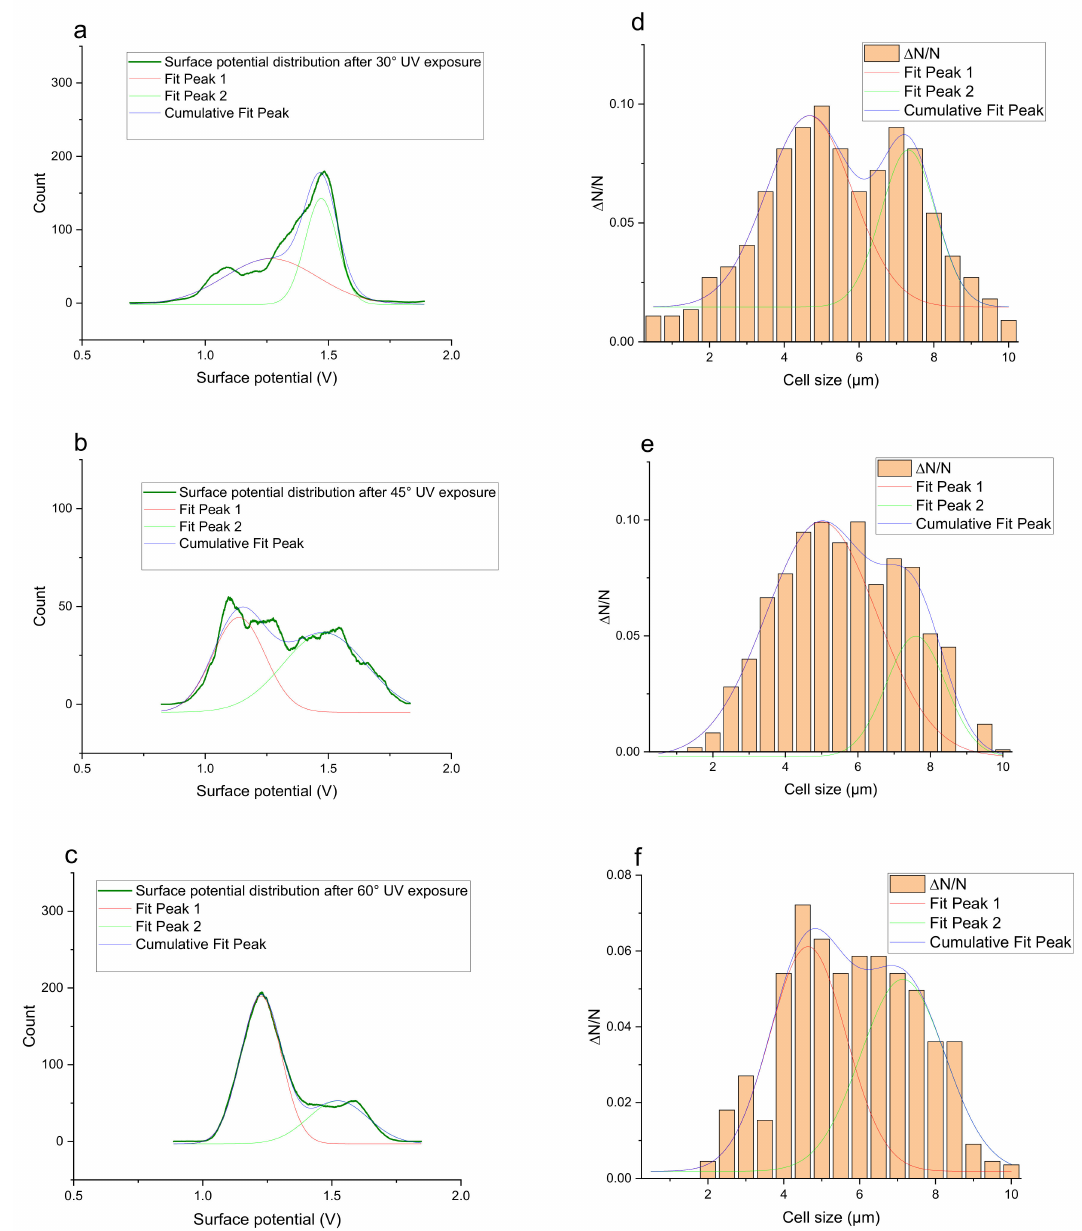
Figure 6. ( a ) Surface potential charge distribution of sample irrigated from 30 ◦ angle. ( b ) Surface potential charge distribution of sample irrigated from 30 ◦ angle. ( c ) Surface potential charge dis- tribution of sample irrigated from 30 ◦ angle. ( d ) Attached yeast cell size distribution on samples irrigated from 30 ◦ angle. ( e ) Attached yeast cell size distribution on samples irrigated from 45 ◦ angle. ( f ) Attached yeast cell size distribution on samples irrigated from 60 ◦